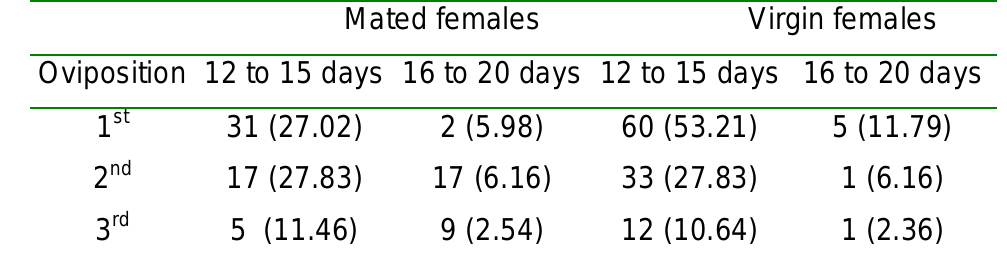
Table 2: Number of D. saccharalis caterpillars that released parasitoid larvae between 12 and 15 days or between 16 and 20 days in each oviposition (1 st , 2 nd or 3 rd ) of mated or virgin C. flavipes